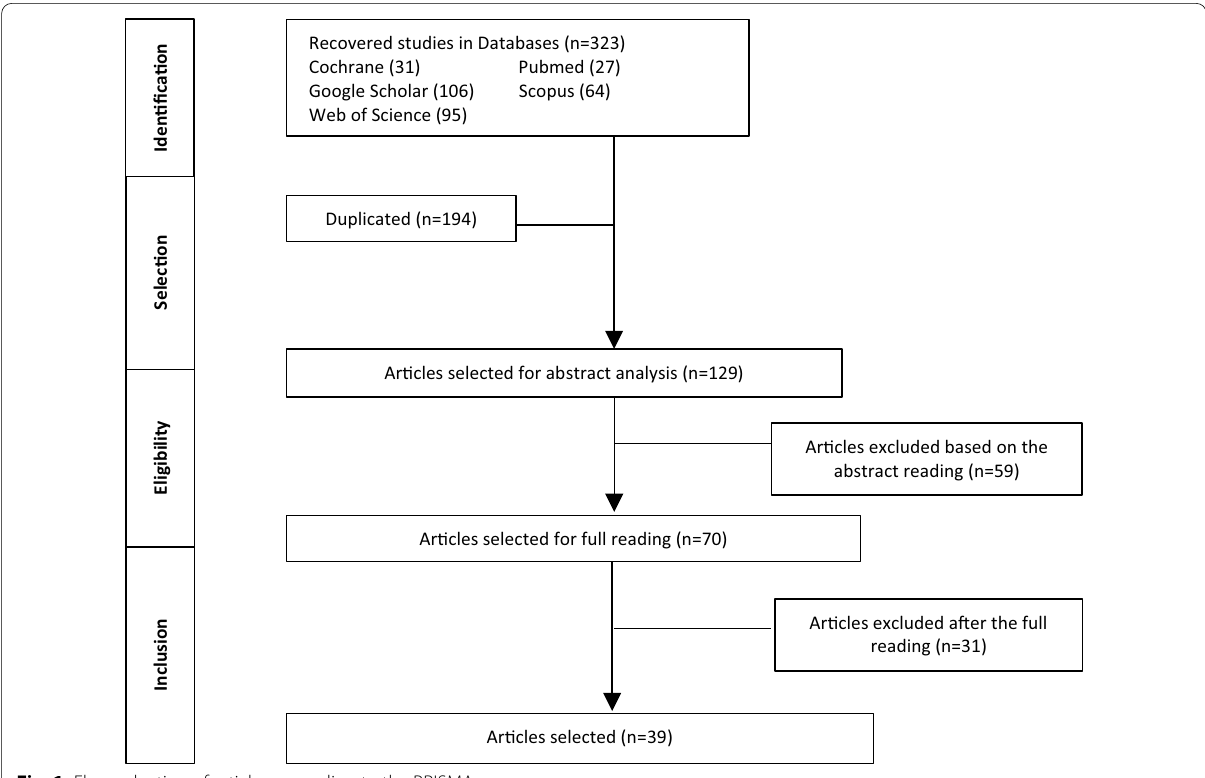
Fig. 1 Flow selection of articles, according to the